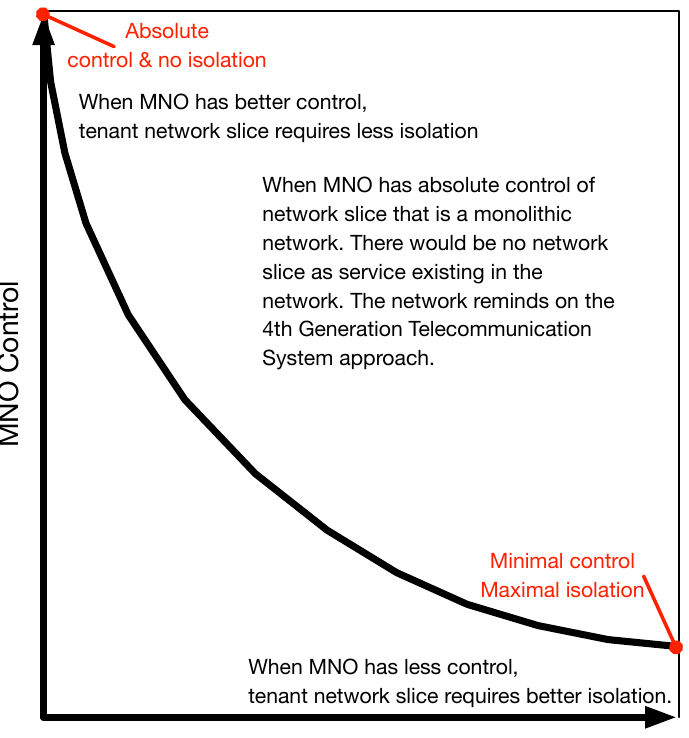
Figure 4. The MNO retains less control on a leased slice with a higher isolation level since more shared functions are replaced by dedicated